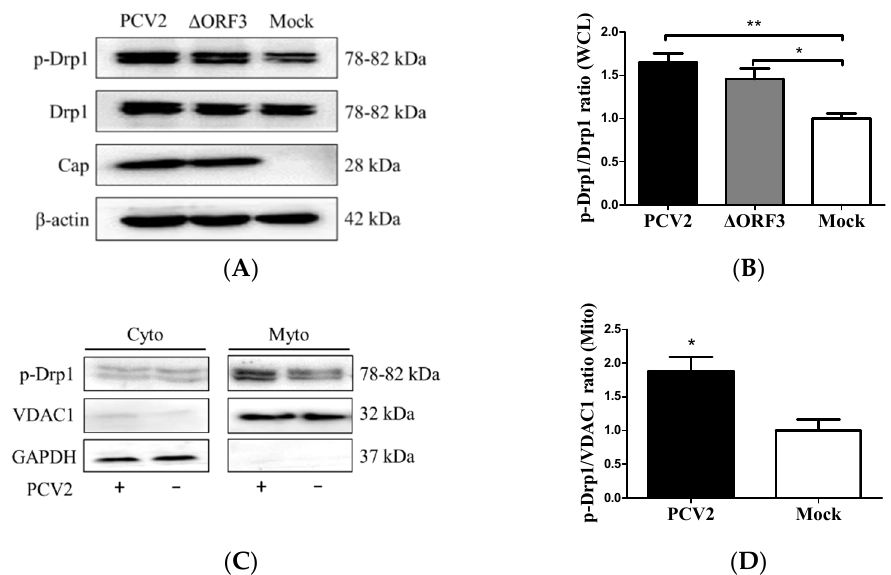
Figure 3. PCV2 stimulated Drp1 phosphorylation and its translocation to mitochondria independent of ORF3. The cells were infected with PCV2 or its mutant Δ ORF3 (MOI = 1) in 24 ‐ well plates for 48 h. Mock ‐ infected cells were used as a control. ( A ) Whole ‐ cell lysates (WCL) extracted from PK ‐ 15 cells infected with PCV2 and Δ ORF3 infection were analyzed using Western blotting with antibodies against Drp1, p ‐ Drp1 (Ser616), Cap (PCV2 capsid protein), and β‐ actin (used as a protein loading control). ( B ) The ratio of p ‐ Drp1/Drp1 in whole ‐ cell lysates (WCL) is shown. ( C ) Cytosolic (Cyto) and mitochondrial (Mito) fractions isolated from PK ‐ 15 cells with or without PCV2 infection were analyzed using Western blotting with p ‐ Drp1, VDAC1, and GAPDH antibodies. GADPH was used as the internal control of cytoplasmic proteins and VDAC1 as that of mitochondrial proteins. ( D ) The ratio of p ‐ Drp1/VDAC1 in the mitochondrial fraction is shown. Bar charts ( B , D ) show the mean ± SEM of three independent experiments. * p < 0.05 and ** p < 0.01.